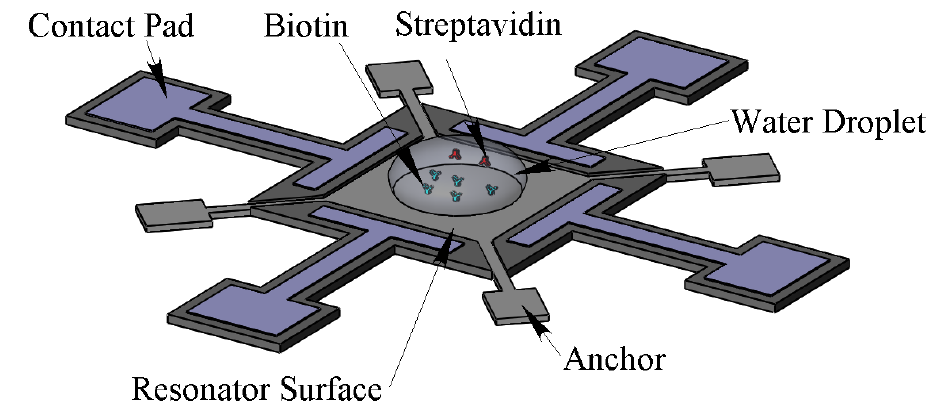
Figure 2. Schematic of the resonator and water droplet containing streptavidin spotted on the center of biotin modified resonator far from the surrounding electrodes. The maximum water droplet volume that can be applied to each resonator is assumed to have covered 78% of the top surface from optical